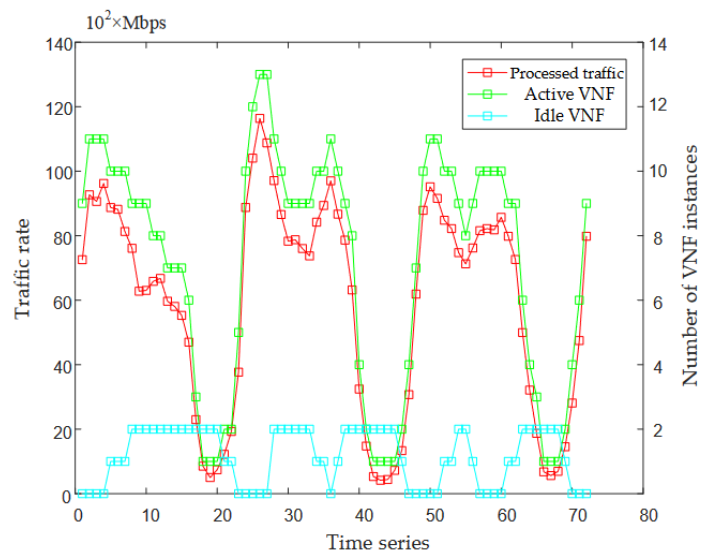
Figure 7. The graph of network traffic and the number of VNFs in different states. As shown in Figure 8, purple, green, and yellow are, respectively, the network over- heads of Method 1, Method 2, and Method 3. Firstly, we analyze the deployment